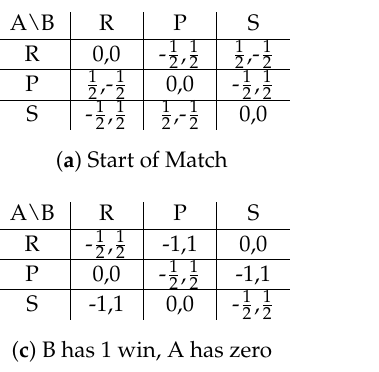
Figure A1. Total payoffs (flow + continuation) for each stage of the